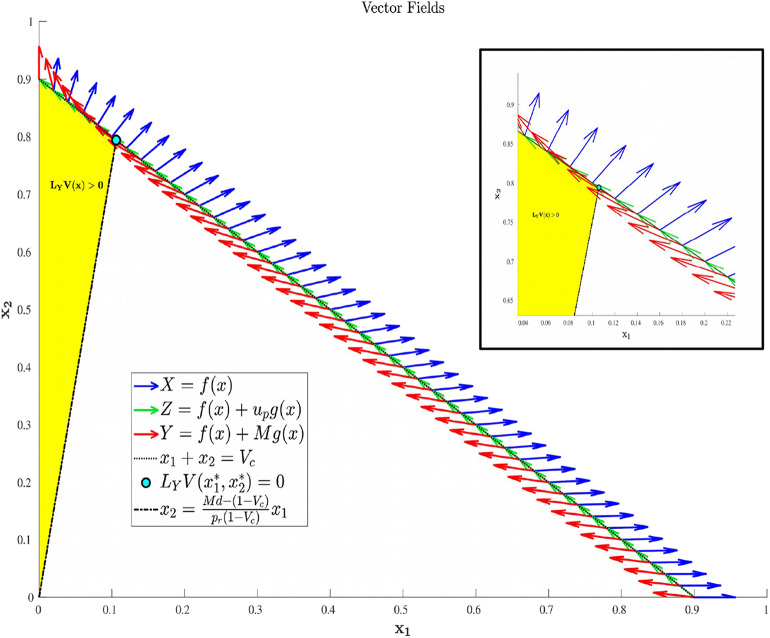
Region in Ωc where LYV(x) is guaranteed to be positive. That is, applying the maximal dosage M results in an increasing cancer population in the yellow-shaded region of phase-space.